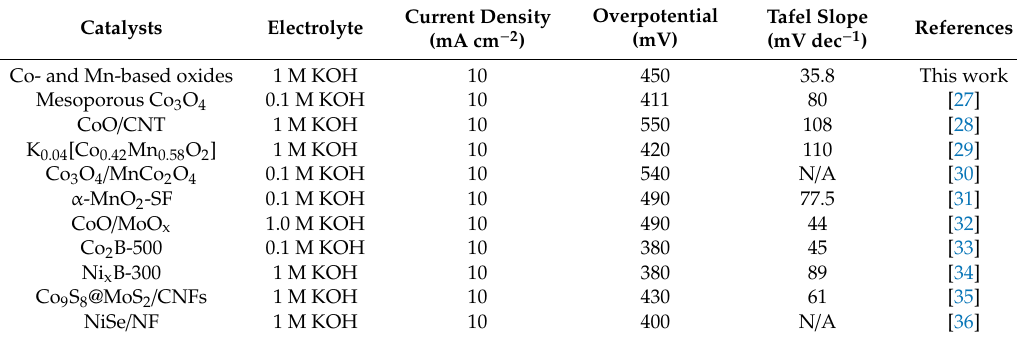
Figure 7. Electrochemical oxygen evolution reaction (OER) properties of Co- and Mn-based the mixed phase materials (Co = 1.2, 2.4 and 2.7). ( a ) Linear sweep voltammetry (LSV) polarization curves measured in 1.0 M KOH with a scan rate of 5 mV · s -1 and ( b ) corresponding Tafel plots. Table 1. Comparison of OER catalytic activity of Co = 2.7 with that of other recently reported, transition metal-based